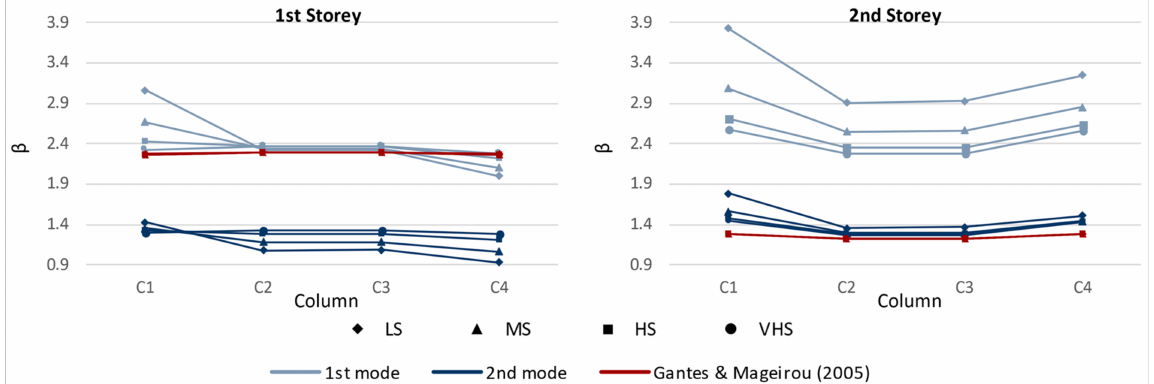
Figure 18. Comparison between effective lengths calculated with different